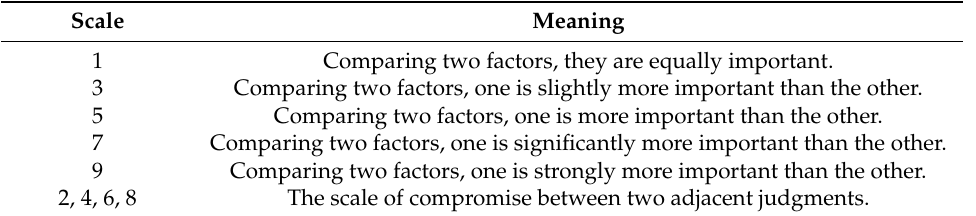
Table 1. Formation criteria of the judgment